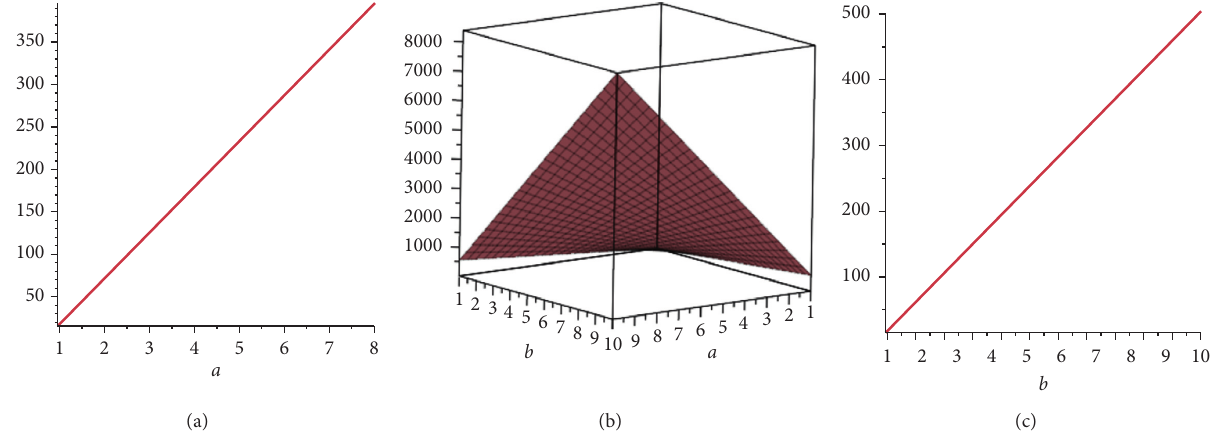
C − II [ a, b ]) , and FI ( Si 2 3